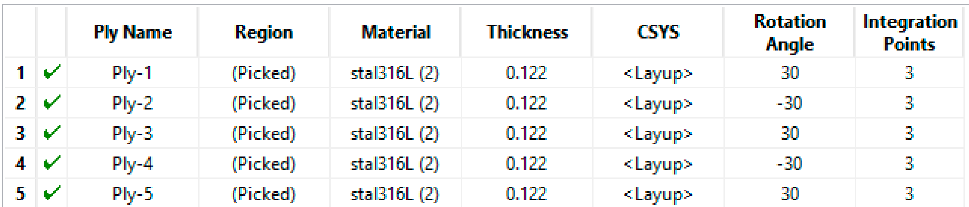
Figure 13. Mesh generated on the model of tested samples.